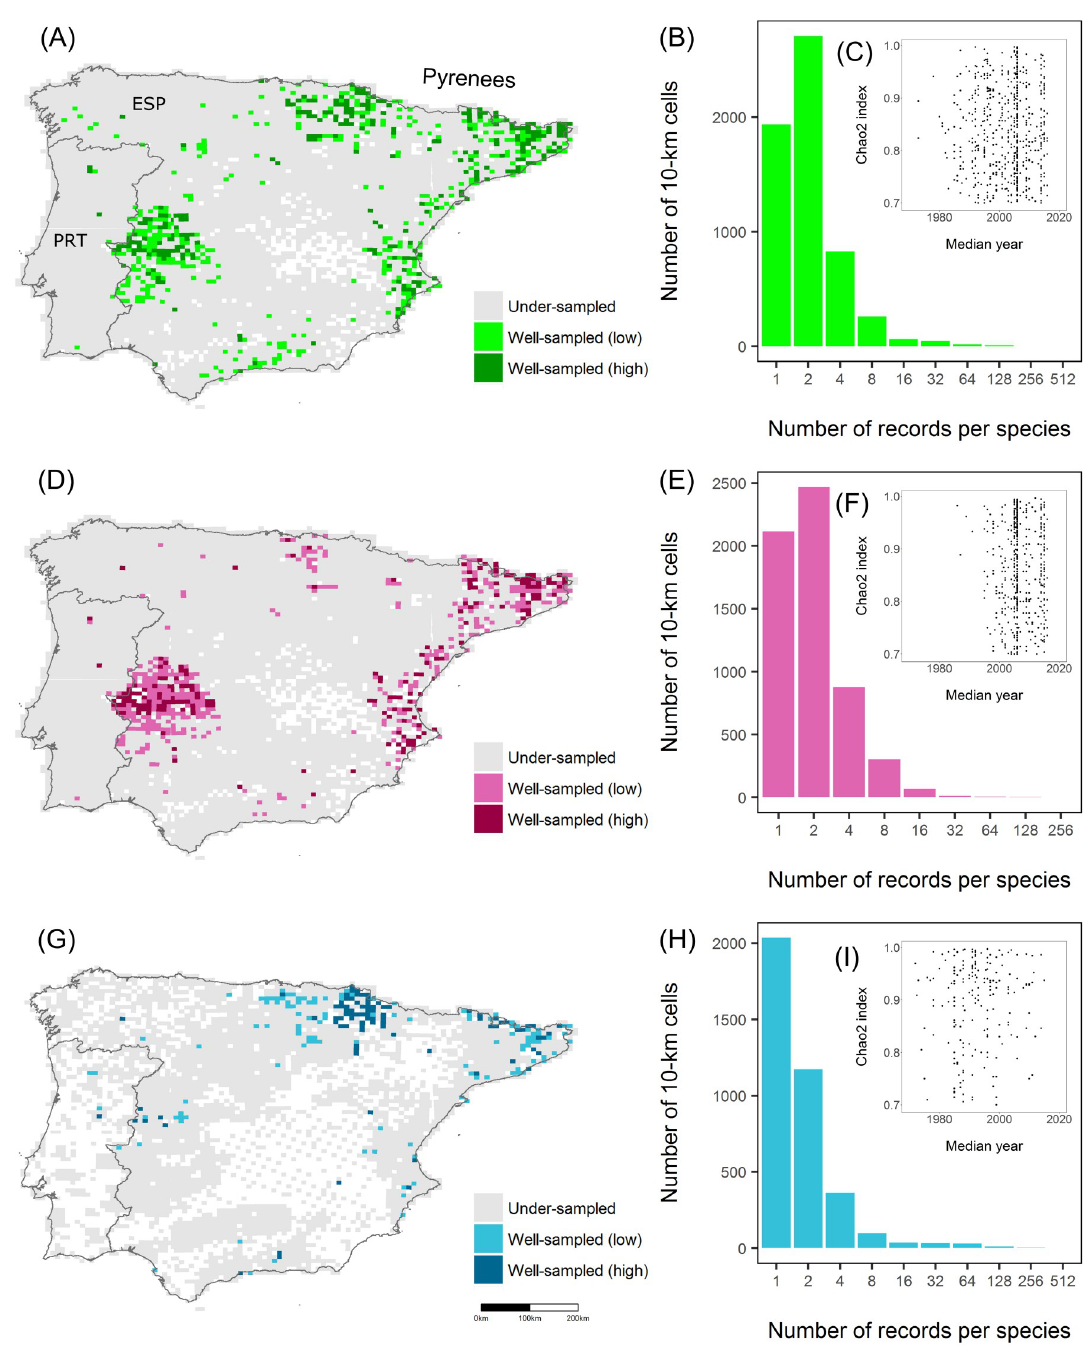
Fig 2. Distribution of sampled 10-km cells across the Iberian Peninsula (PRT: Portugal, ESP: Spain) for (A) full dataset, (D) non- small mammals (Lagomorpha, Artiodactyla, Carnivora, Chiroptera and Erinaceidae), and (G) small mammals (Rodentia and Soricidae) . Color shades highlight well-sampled cells according to the strict and lax criteria. Blank cells retained no data. The distribution of cells by their number of records per species (classes expressed as Preston octaves) is shown for the (B) full dataset, (E) non-small mammals, and (H) small mammals. The relationship between the Chao2 completeness index and the median year in which records were collected is shown for the (C) full dataset, (F) non-small mammals, and (I) small mammals. Records derived from the Global Biodiversity Information Facility and the Spanish and Portuguese national atlases.